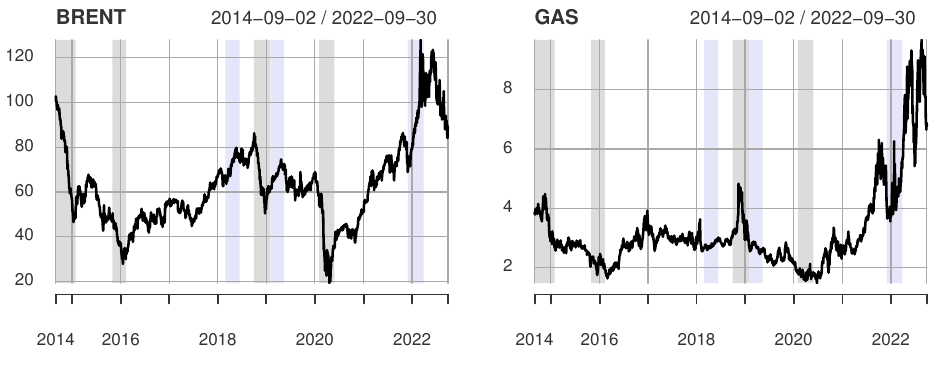
Figure 1. Prices of oil and